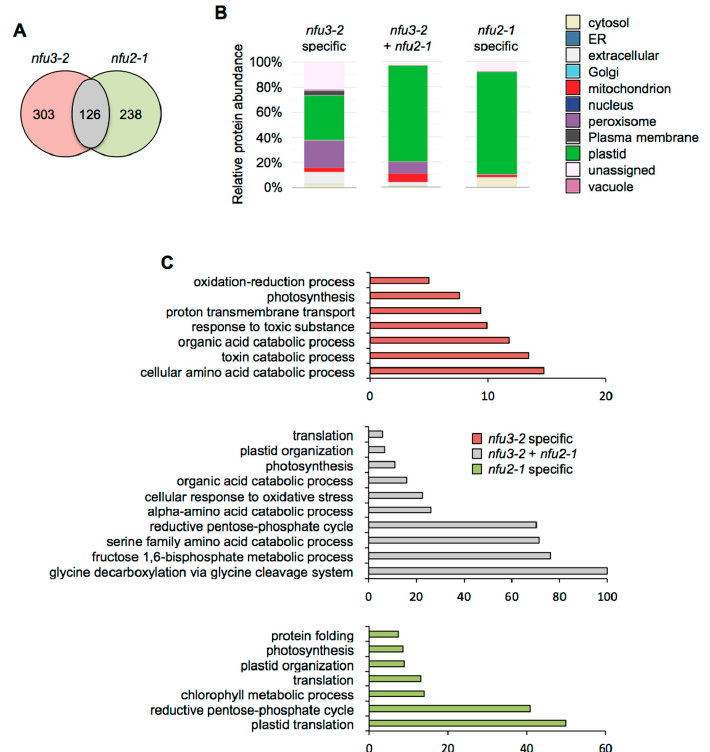
Figure 5. Comparison of proteins whose abundance is increased in the Arabidopsis thaliana nfu3-2 and nfu2-1 mutants when compared to the wild type. Venn diagram comparing the proteins whose abundance is increased in both nfu3-2 and nfu2-1 mutants (whole seedlings). Seedlings were grown as described in [21]. Venn diagram was done with Venny 2.1 (https: // bioinfogp.cnb.csic.es / tools / venny /